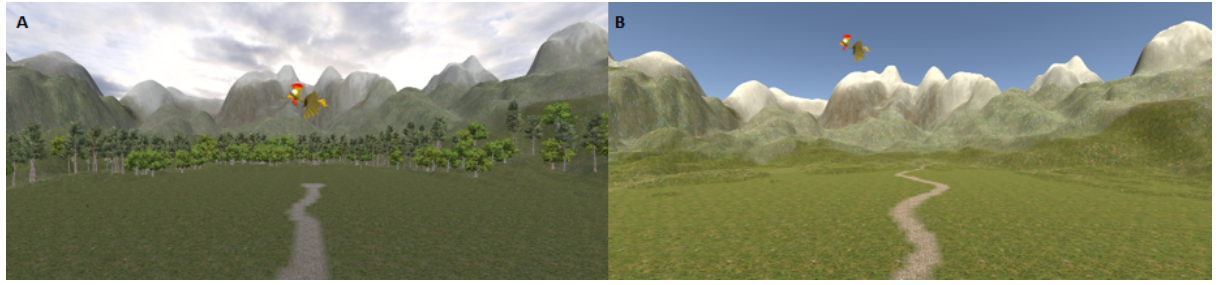
Figure 2. Exemplary scene of the gameplay, (A) as implemented in step 1 (healthy individuals) and (B) after the modifications performed in step 2 (patients with right hemispheric stroke and hemispatial